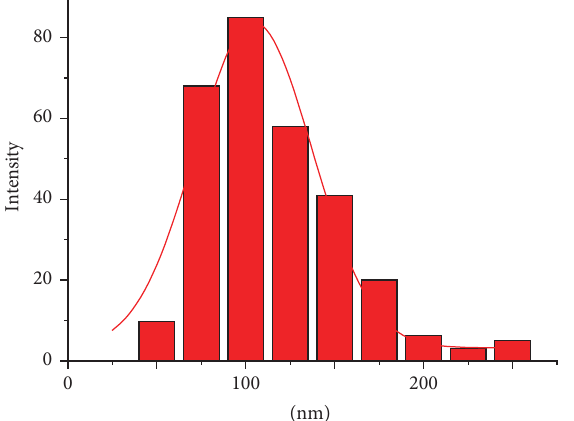
Figure 13: Particle size distribution of target Co powders sample